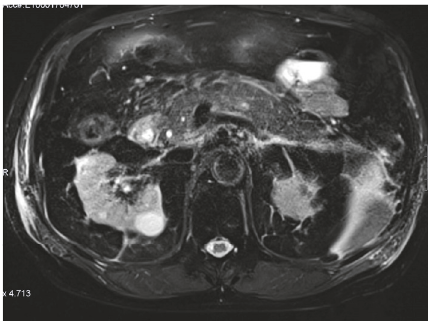
Figure 2: Fat suppressed T2W axial image showing both peripan- creatichazinessandedema(arrows)consistentwithacuteinterstitial